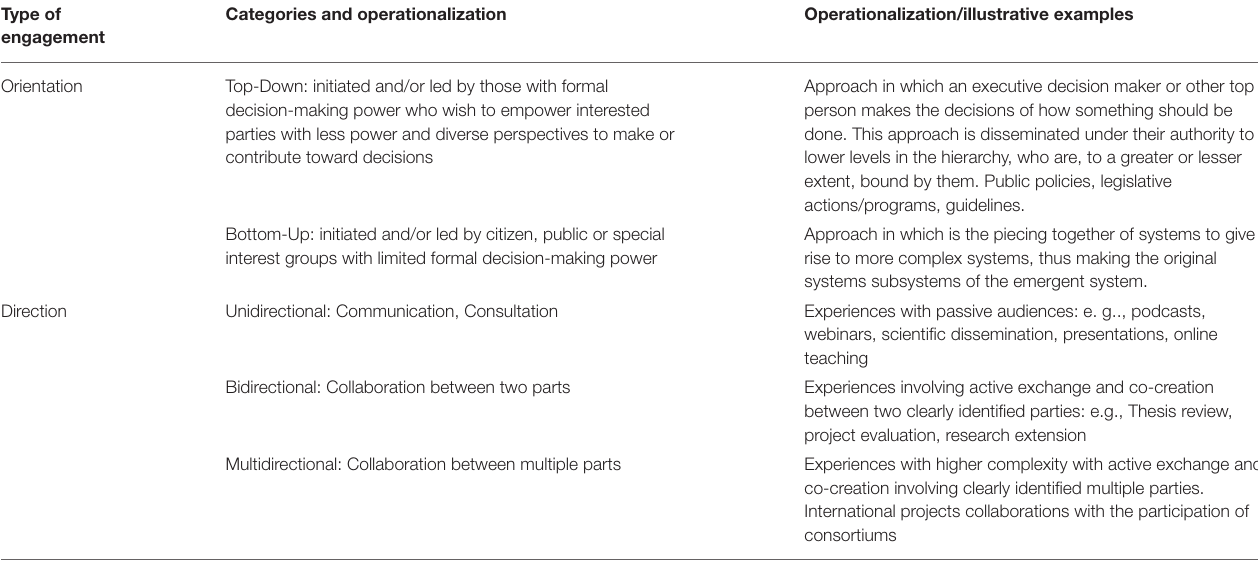
TABLE 1 | Honduras diaspora engagement for